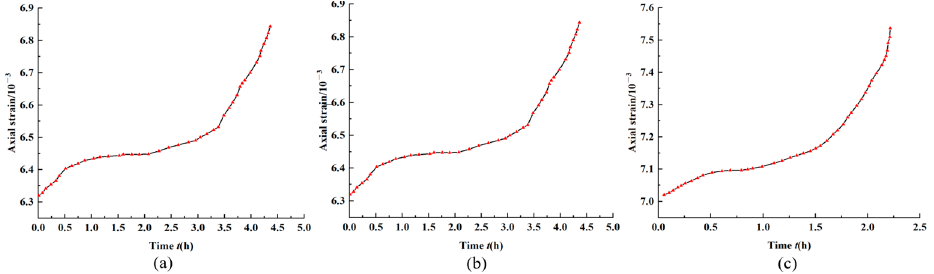
Figure 14. Curve of accelerated creep stage under different pore pressure; ( a ) Pore water pressure 0.5 MPa; ( b ) Pore water pressure 1.0 MPa; ( c ) Pore water pressure 1.25 MPa.